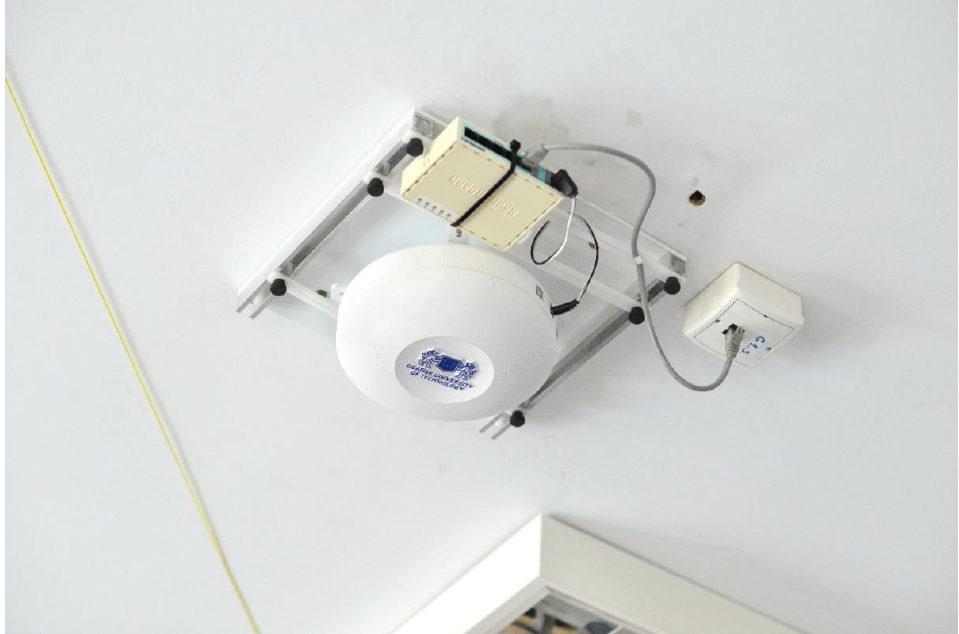
Figure 8. The ESPAR antenna integrated together with the custom-made WSN board installed within a custom-made housing and mounted on the ceiling.